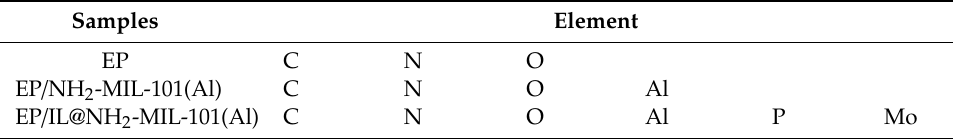
Table 1. EDS analysis of EP, EP / NH 2 -MIL-101(Al), and EP / IL@NH 2